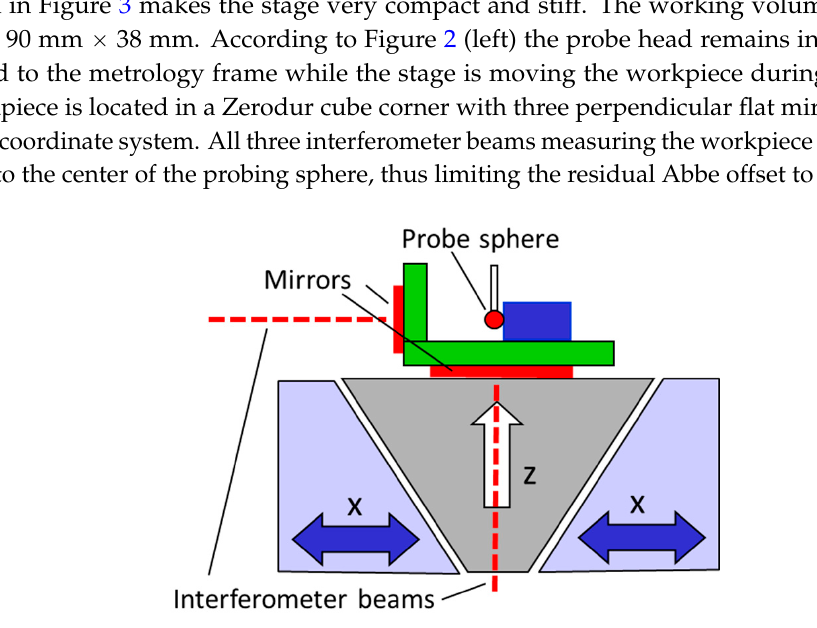
Figure 3. Principle of the Abbe free CMM stage at METAS. y -axis perpendicular to drawing plane.